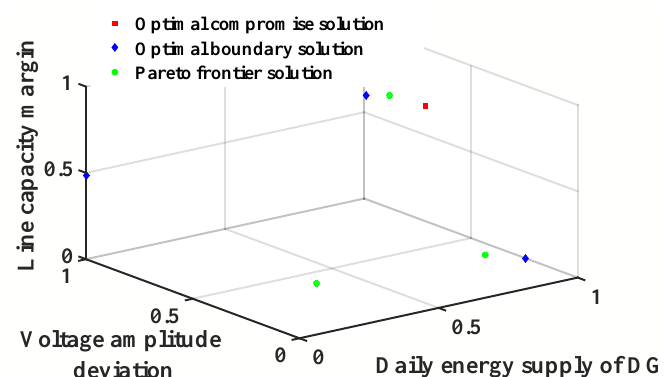
Figure 5. The distribution map of objective functions of external archives. Figure 5. The d istribution map of objective functions of external archives.